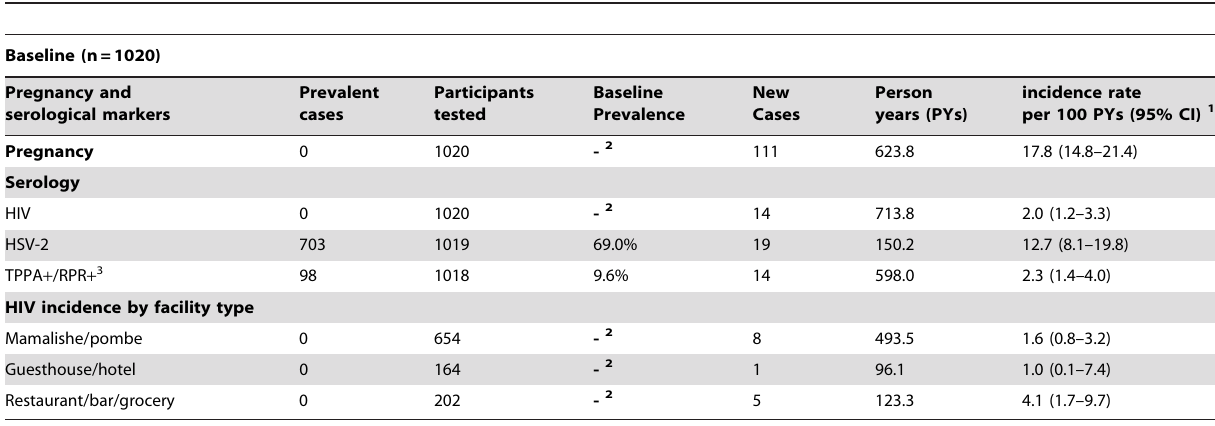
Table 3. Prevalence and incidence of pregnancy, HIV and STIs among eligible women attending at baseline (n=1020).